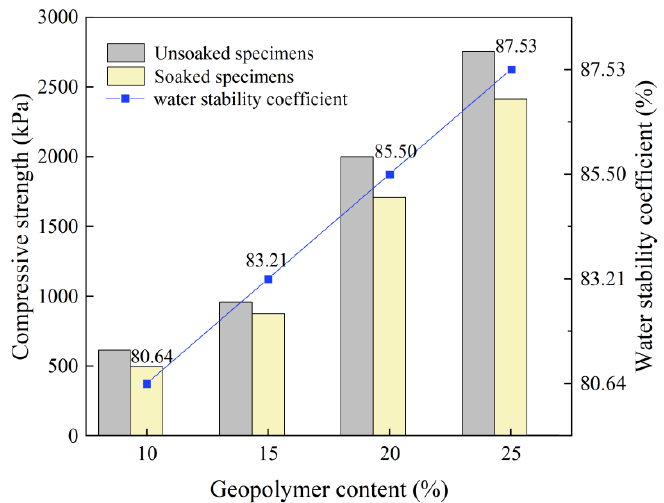
Figure 6. UCS of unsoaked and soaked geopolymer-stabilized soil .